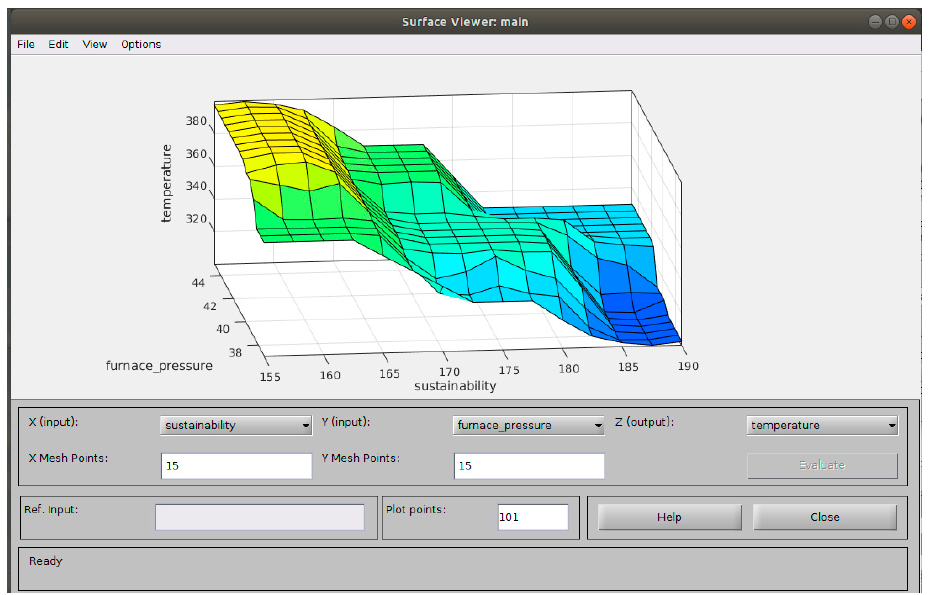
Figure 6. Visualization fuzzy inference in RuleViewer.